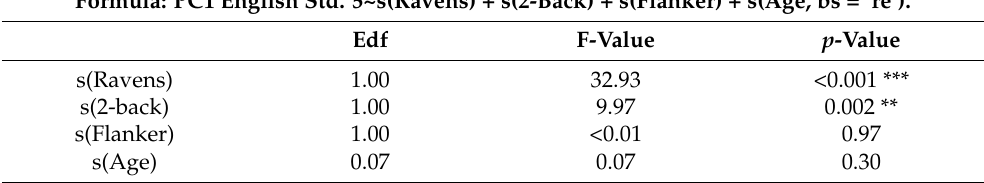
Table A4. Output of the generalized additive model for the English literacy in Std. 5.